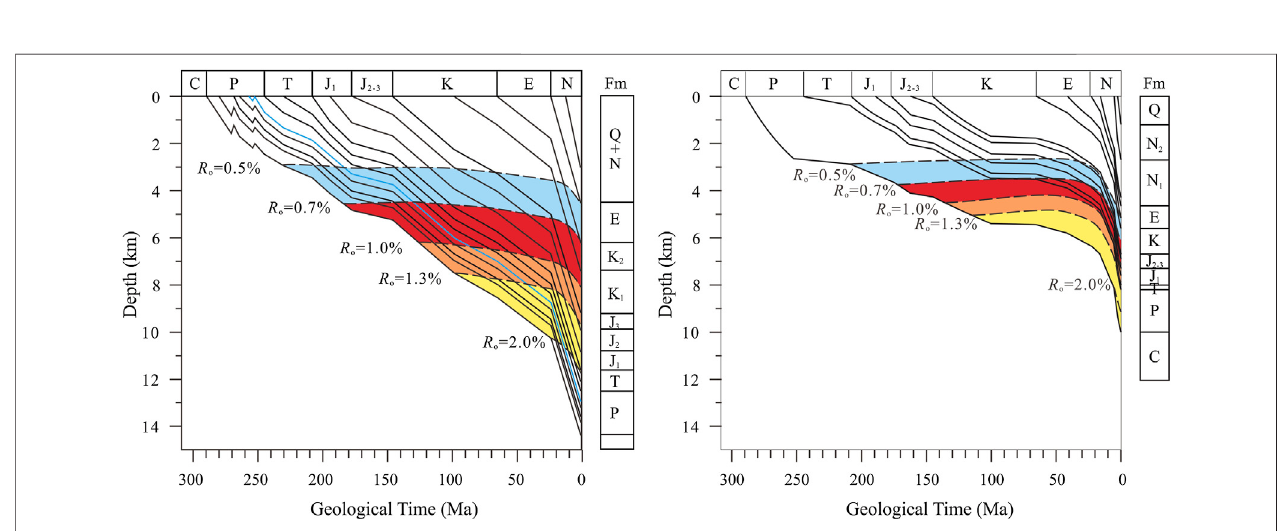
FIGURE7| Burialevolutionandhydrocarbongenerationhistoryofsourcerocksinthemiddleandwesternpartsofsouthernmargin. (A) Middlepartofsedimentary sag in the middle of southern margin (see Figure 6 for location); (B) Middle and west parts of Sikeshu Sag in the west of southern margin (see Figure 6 for location).